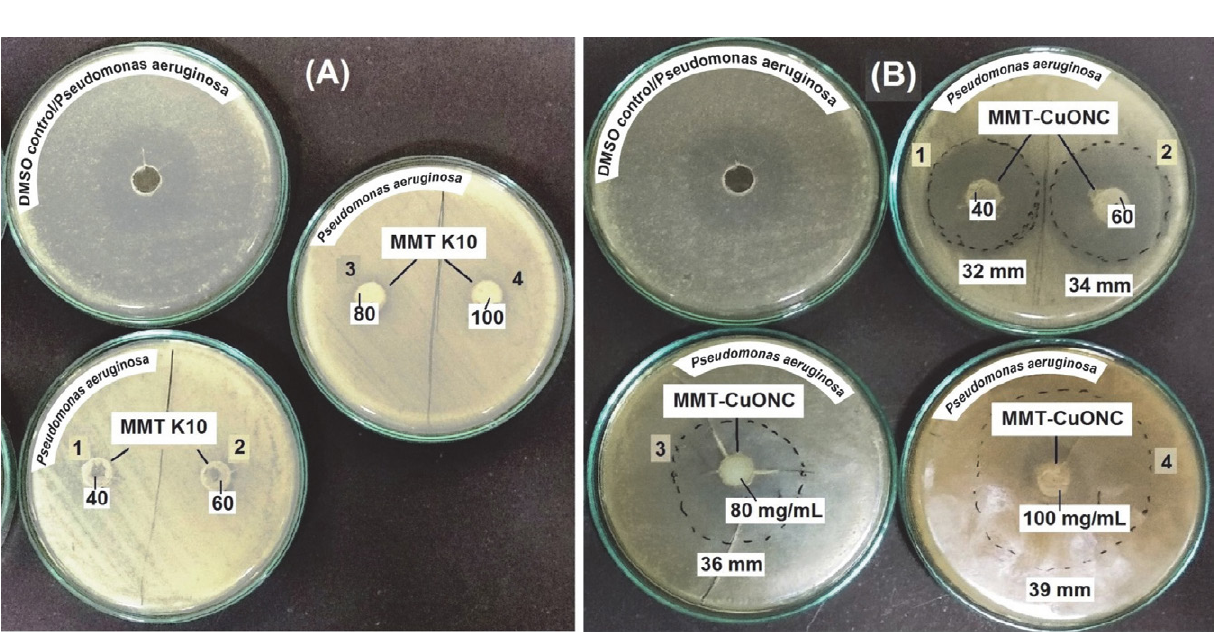
Figure 6: Zone of inhibition of MMT K10 (A) and synthesized MMT supported copper oxide nanoparticles (B) against Pseudomonas aeruginosa (Gram negative) at different concentrations (40, 60, 80, 100